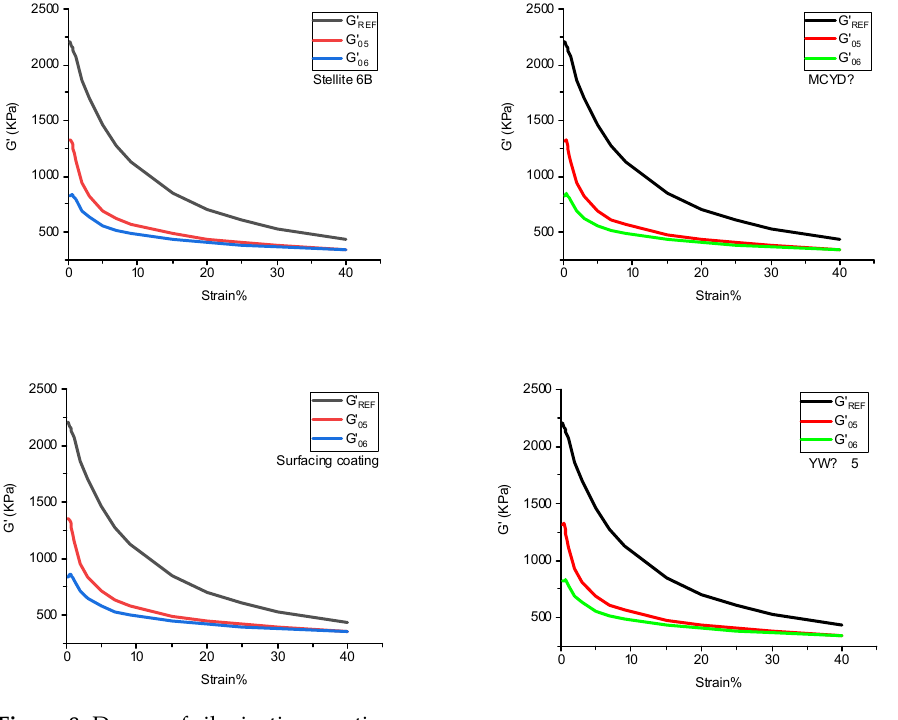
Table 8. Silanization reaction index of NR/BR composites after friction with different metals.